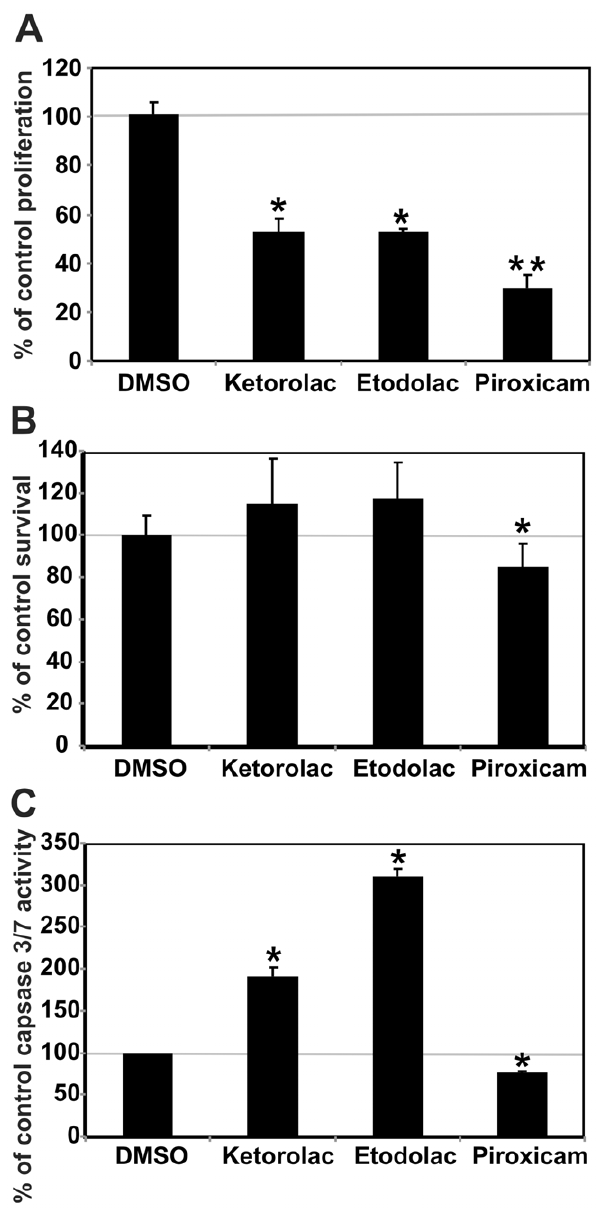
Figure 6. NSAIDs differentially affect apoptosis and prolifera- tion of gastric epithelial cells in vitro. A. All three NSAIDs tested decreased proliferation of AGS cells compared with vehicle (DMSO) alone, as measured by changes in CFSE incorporation over 3 days of culture, with the largest decrease seen in piroxicam-treated cells (* indicates p , 0.05 vs. vehicle; ** p # 0.04 vs. vehicle, ketorolac, or etodolac). B. Survival of AGS cells measured by a tetrazolium dye-based assay is significantly decreased by exposure to piroxicam, but not to keterolac or etodolac. Data shown (mean 6 SD; n=12) was obtained after 4 hrs of treatment. * indicates p , 0.05 compared with DMSO control. C. Treatment with the NSAIDs ketorolac or etodolac, but not piroxicam, significantly increased apoptosis as indicated by increased caspase 3 and 7 activity, shown here at 24 hrs (mean 6 SD; n=3).